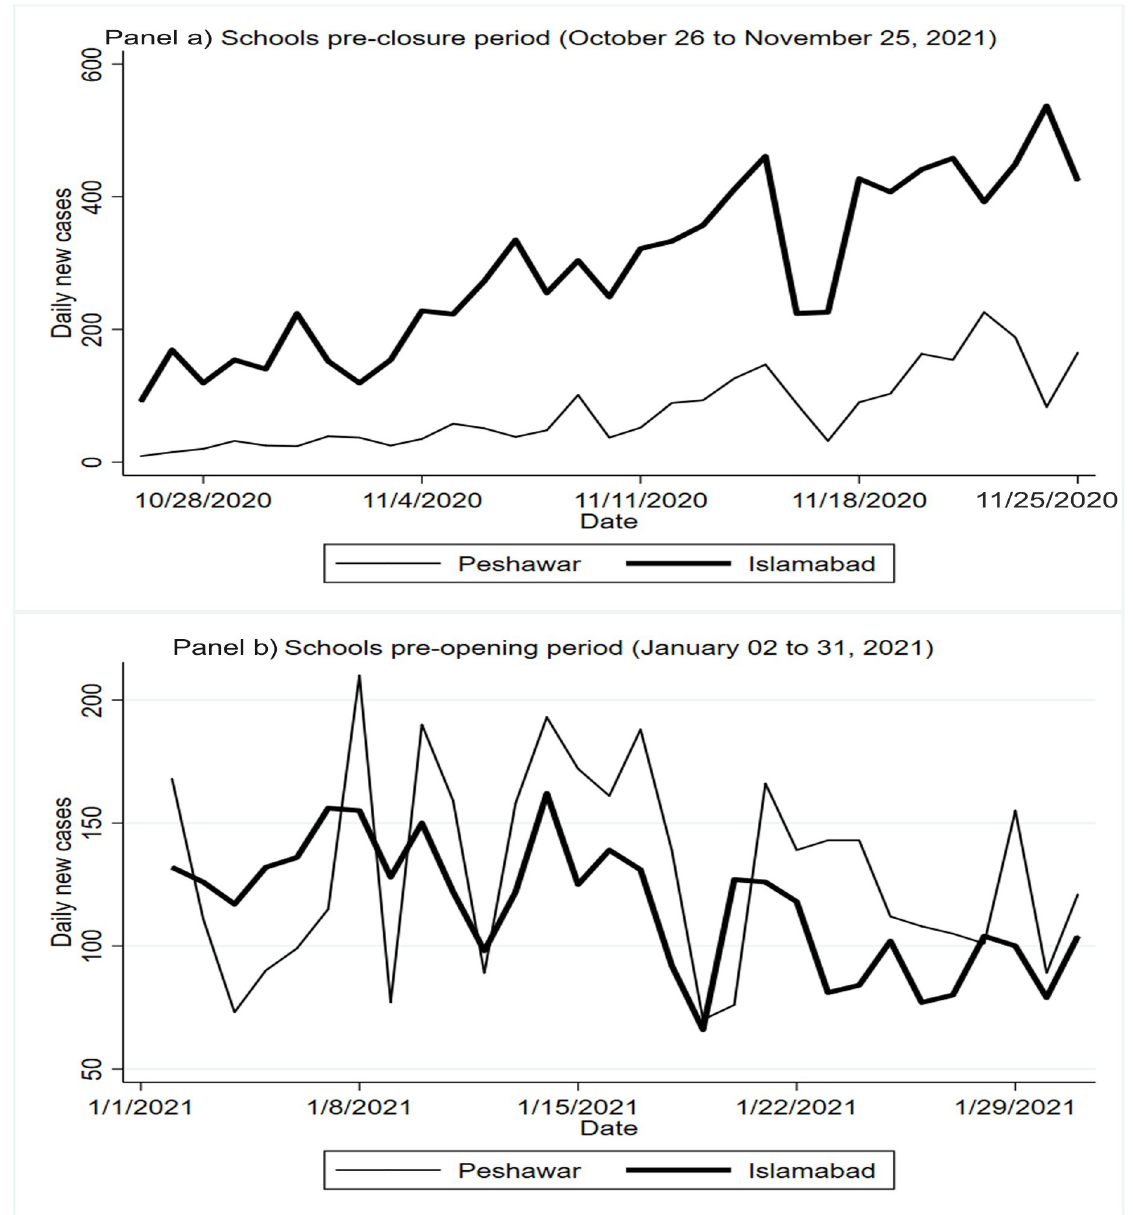
Fig 2. COVID-19 incidence in Islamabad and Peshawar pre-school closure and pre- school reopening.